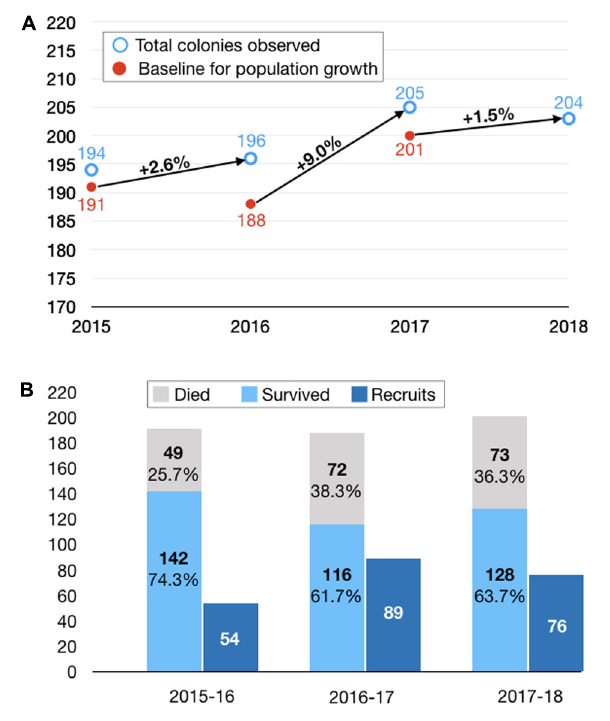
FIGURE 3 | Net population change broken down by survival, mortality and recruitment. (A) Net population changes over three 1-year intervals. In calculating the percentage population changes, we adjusted the baseline at the start of each interval to eliminate colonies that were